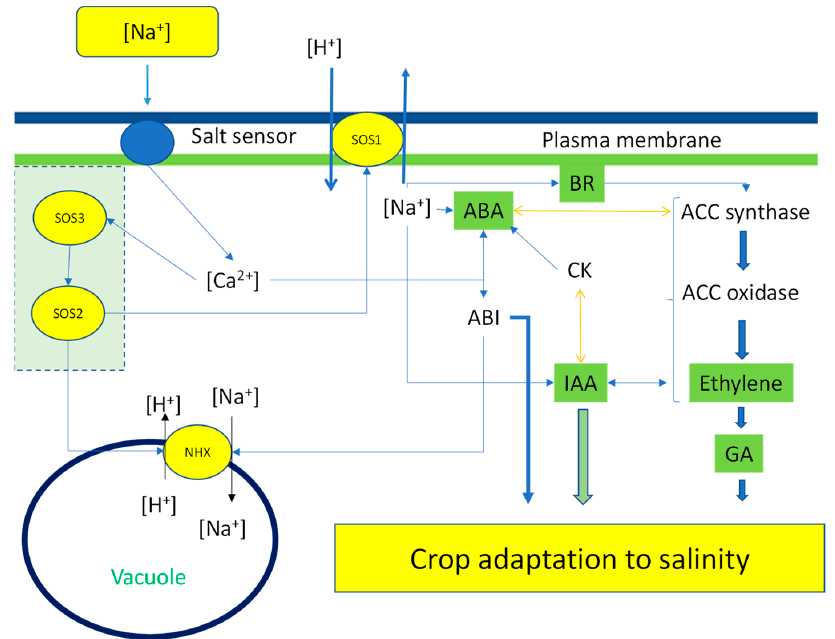
Figure 5. Under salinity stress due to high sodium concentration, the cell activates several protective systems that lead to adaptation. The sodium sensor promotes an increase in calcium in the cytoplasm that regulates the SOS1 and SOS3. These complexes are responsible for sodium accumulation in the vacuole and extrusion of sodium in the apoplast out of the cell. Sodium and calcium regulate the plant hormone network and interact with each other to allow for crop adaptation to high-salinity conditions.